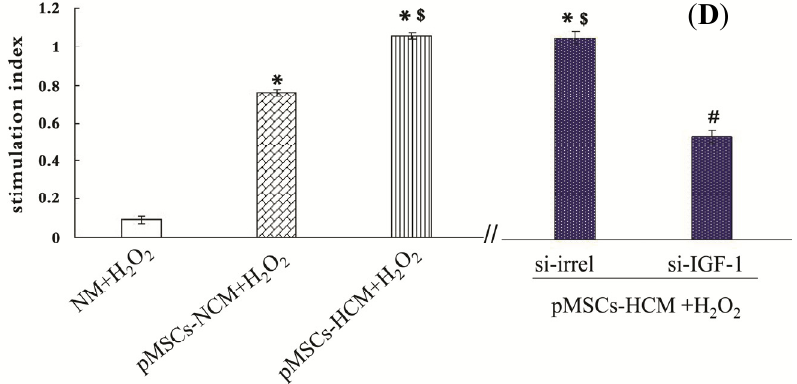
Figure 5. pMSCs hypoxia culture medium has stronger effect on limiting H caco2 apoptosis via IGF-1 compared with pMSCs normoxia culture medium. ( A ) After five days culture, untreated caco2 cells in NM, H pMSCs-NCM, si-irrel-pMSCs-HCM or si-IGF-1-pMSCs-HCM, percentage of apoptotic cells (early apoptosis is FITC-positive, late apoptosis is FITC- and propidium iodide-postive) were analyzed by FACS; and ( B ) Data was expressed as the mean ± SEM of experiments repeated three times. º p < 0.05 versus NM. * p < 0.05 versus NM + H